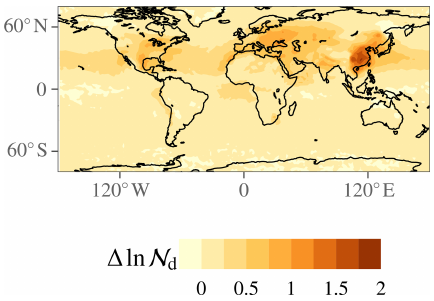
Figure 3. Anthropogenic ln N d change.